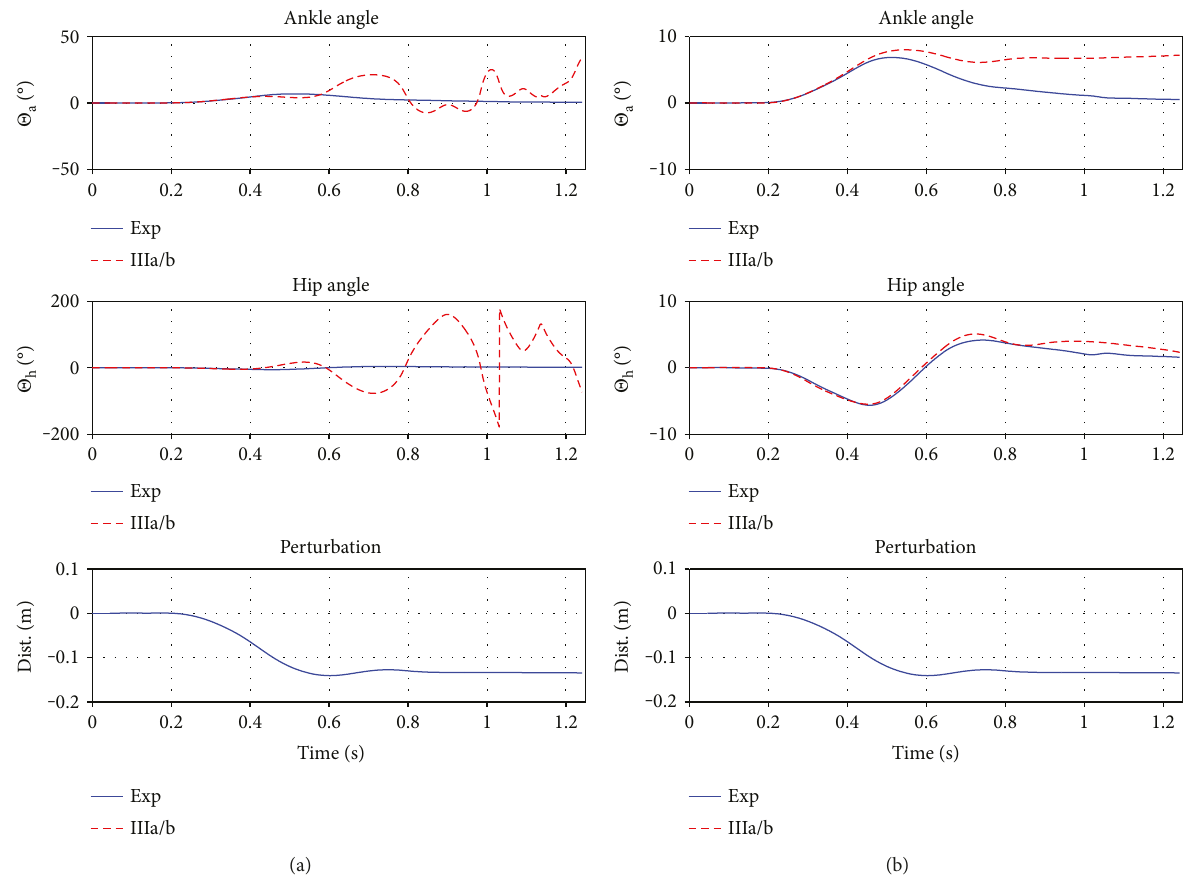
Figure 7: (a) Controller IIIa, best fi t, with an remaining error of 45.73 deg/ts . (b) Controller IIIb, best fi t, with an remaining error of 2.7 deg/ts . Both fi tted to the same experimental trial (5)14200lt. First plot is the ankle trajectory, second is the hip, and third is the perturbation. While IIIa fails to stabilize (no torque coupling), even the introduction of simple one to one torque coupling (IIIb) is enough to (1) stabilize the system and (2) almost reproduce the experimental